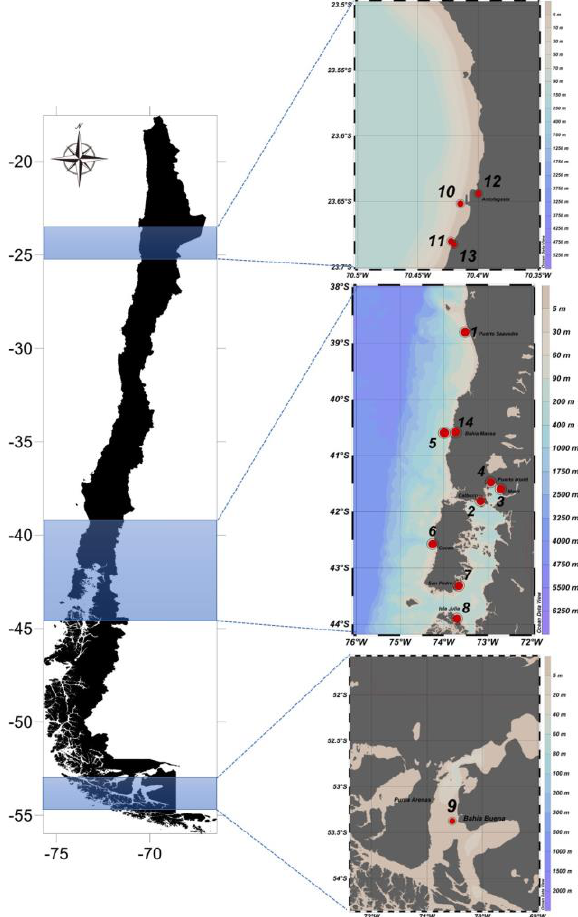
Figure 2. Sampling stations for prospective HAB monitoring program in Chile: at (1) Puerto Saavedra in Araucan í a ( − 38.804; − 73.516), (2) Paso Quenu in Calbuco ( − 41.807; − 73.1672), (3) Metri in Puerto Montt ( − 41.597; − 72.7056), (4) Club de Yates in Puerto Montt ( − 41.475; − 72.934), (5) Bah í a Mansa open ocean ( − 40.581; − 73.737), (6) Cucao in Chilo é Island ( − 42.574; − 74.259), (7) Isla San Pedro in Chilo é Island ( − 43.313; − 73.662), (8) Isla Julia in Melinka ( − 43.901; − 73.704), (9) Bah í a Buena in Punta Arenas ( − 53.617; − 70.914), (10) Puerto in Antofagasta ( − 23.652; − 70.415), (11) Capilla in Antofagasta ( − 23.680; − 70.423), (12) Puerto Costa in Antofagasta ( − 23.644; − 70.399), (13) Capilla Costa in Antofagasta ( − 23.683; − 70.420), (14) Bah í a Mansa coast ( − 40.581; −